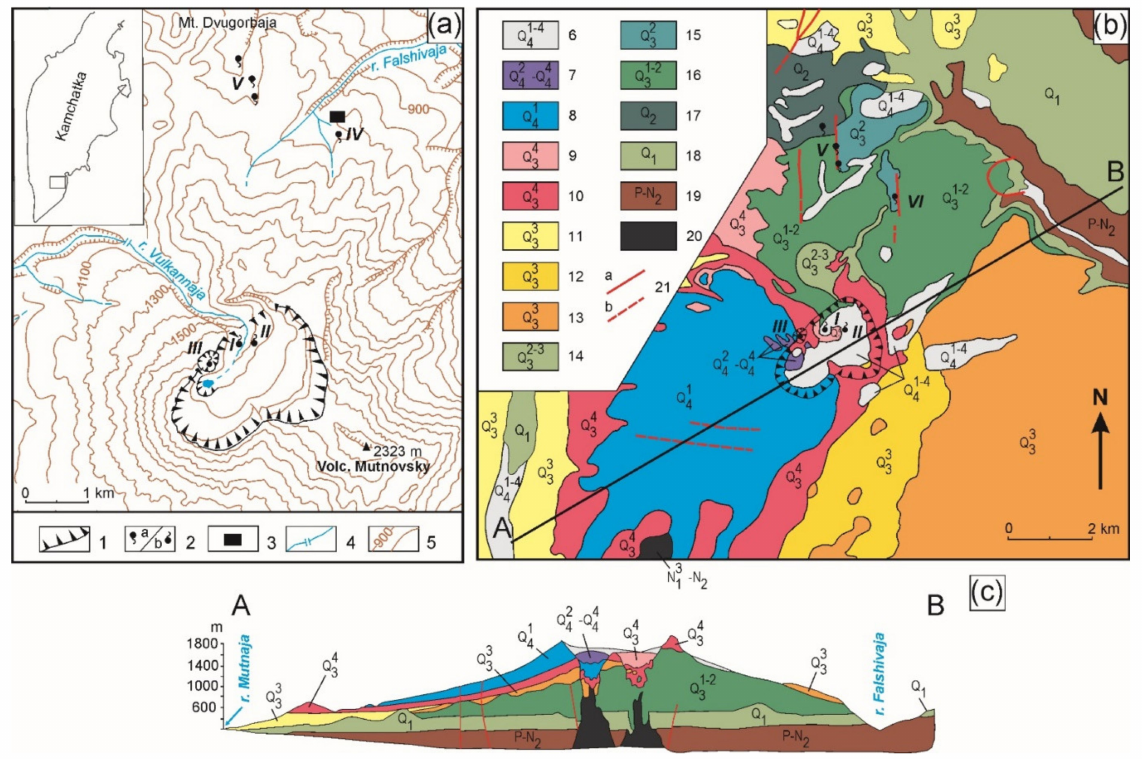
Figure 1. The scheme of the Mutnovsky volcano area ( a ), geological map ( b ) and ( c ) representa- tive A-B (line) cross-section (modified after [23]). Symbols: 1—scarps of craters and calderas